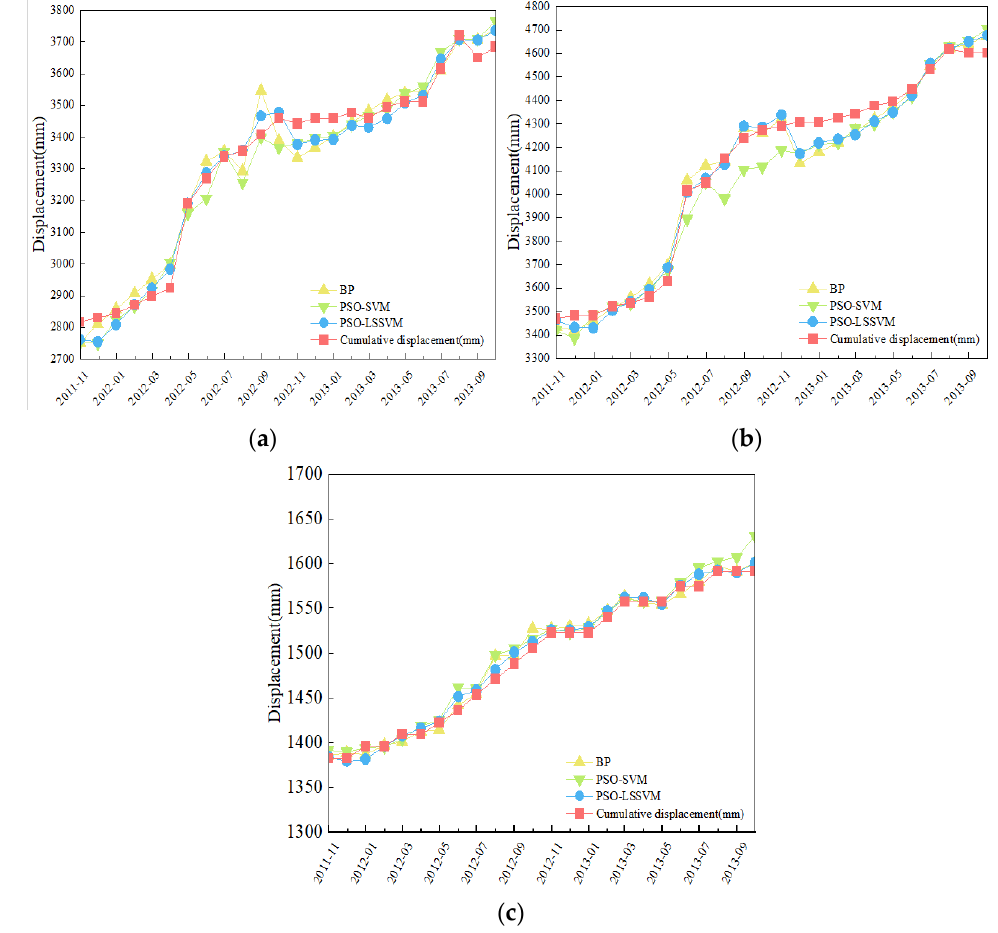
Figure 8. The CD predicted results: ( a ) ZG85; ( b ) ZG86; ( c ) ZG87. Table 4. The error of the CD of each model.